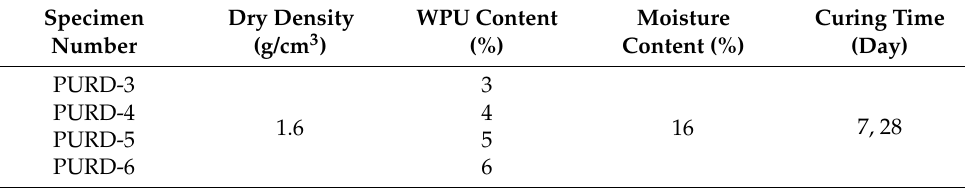
Table 3. Test scheme for RA reinforced with different contents of WPU.